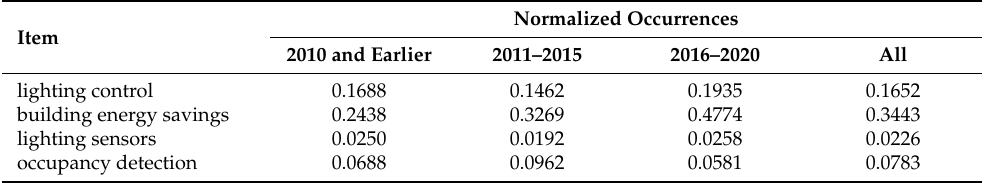
Table 10. Normalized occurrences of lighting sensors, occupancy detection, lighting control and building energy savings, determined by using